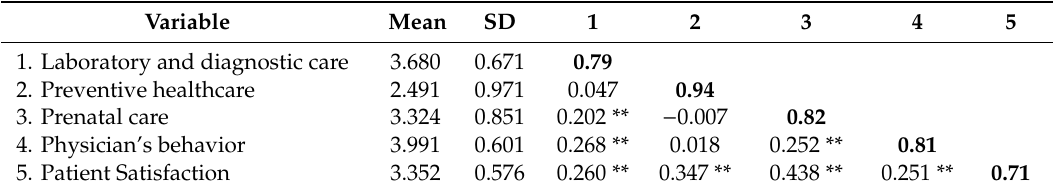
Table 2. Descriptive statistics, correlations, and reliability.